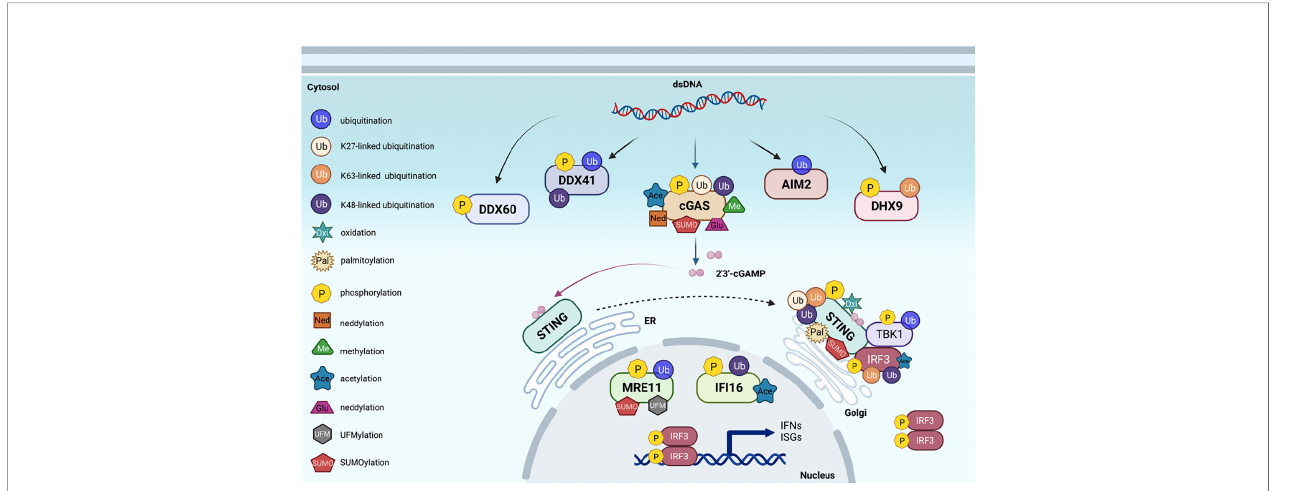
FIGURE 1 | Post-translational modi fi cations of proteins in cytosolic DNA sensing signaling. An overview of cytosolic DNA sensing signaling. Reported post- translational modi fi cations on each DNA sensing signaling pathway member are earmarked by indicated icons. The cartoon illustration is generated by